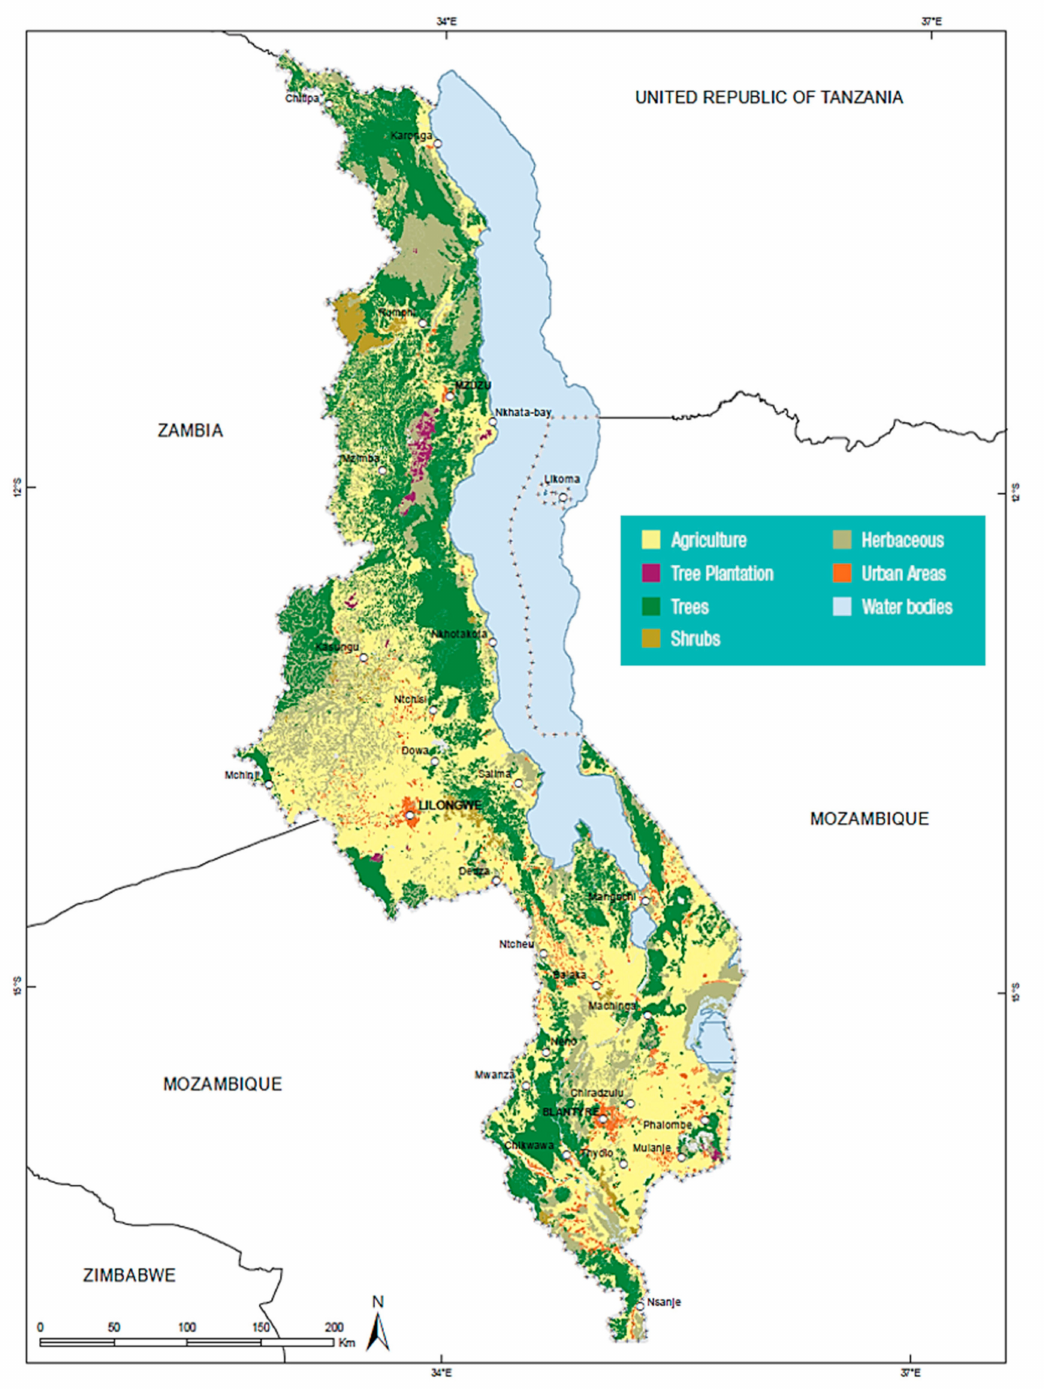
Figure 1. Vegetation map of Malawi. Source: Adapted from FAO